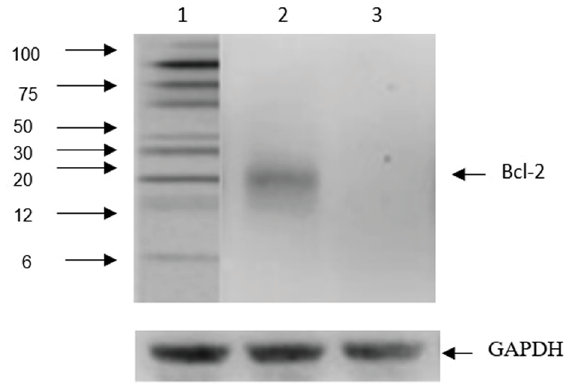
FIGURE 4 - Effect of mace extract treatment on Bcl-2 protein expression in KB cells. Lane 1 -Marker Lane; Lane 2- Bcl-2 protein expression in control KB cells; Lane 3 – Bcl-2 protein expression in extract treated KB cells.